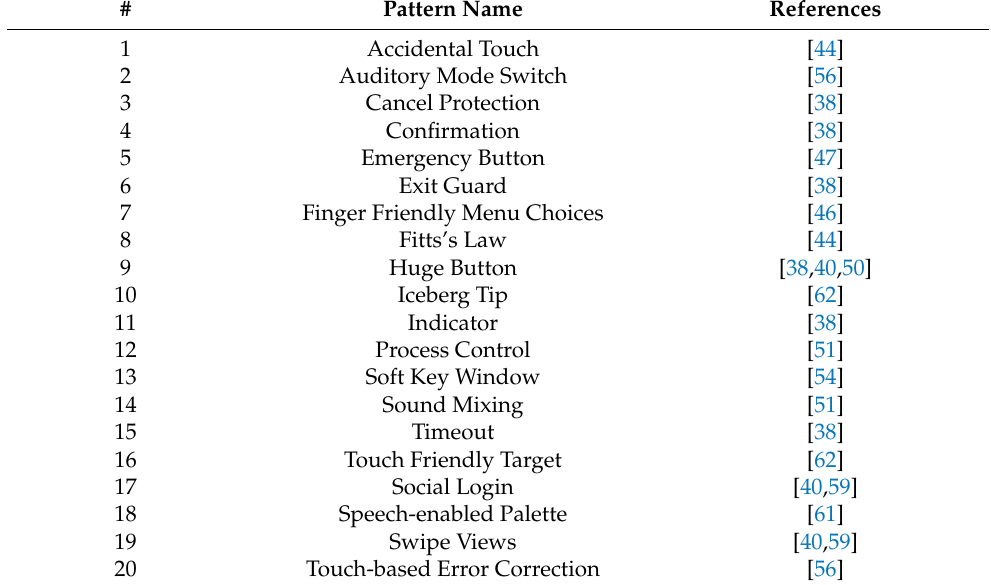
Table 7. Action, Control, and Confirmation MUIDPs.